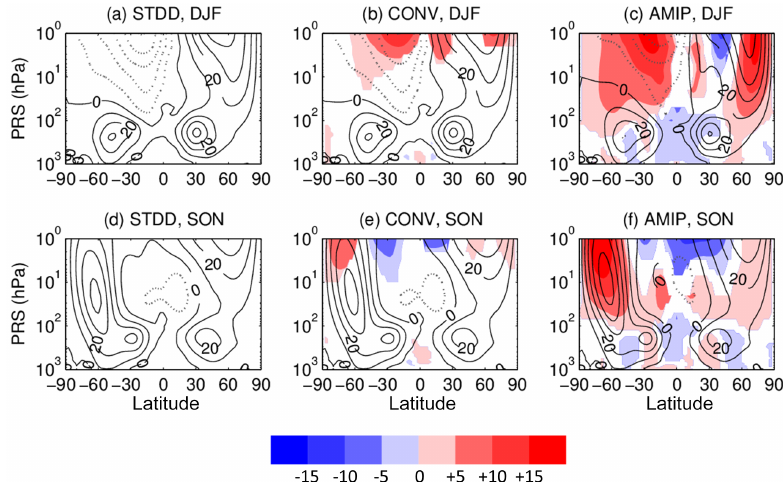
Figure 1. The climatological zonal mean zonal wind in the JRA-55 family data sets for (a–c) DJF and (d–f) SON in black contours. Panels (a, d) are for STDD, (b, e) for CONV, and (c, f) for AMIP. The contour interval is 10ms − 1 . Panels (b, c, e, f) also plot differences from STDD using color shades (see the color bar) that are statistically significant at the 95% level. When taking differences of CONV from STDD, the STDD data after the 1972–1973 season are used. PRS is pressure.